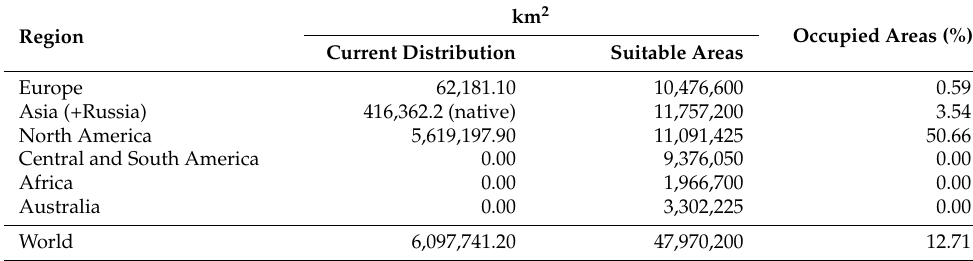
Table 3. Current distribution and suitable areas (km 2 ) of the Japanese beetle. Data on current distribution were extrapolated by [59] while suitable areas under current conditions were derived by INLA SPDE. Percentage of current distribution on suitable areas is also